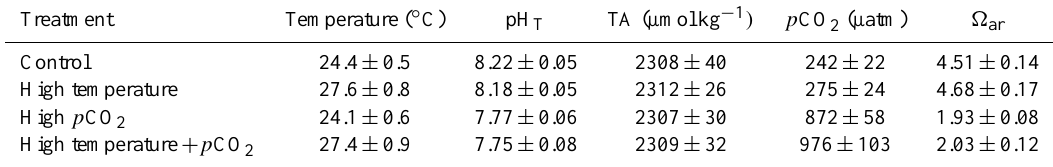
Table 1. Physical and chemical conditions maintained for the duration of the experiment (mean ± SD). Table from Foster et al. (2015). Treatment